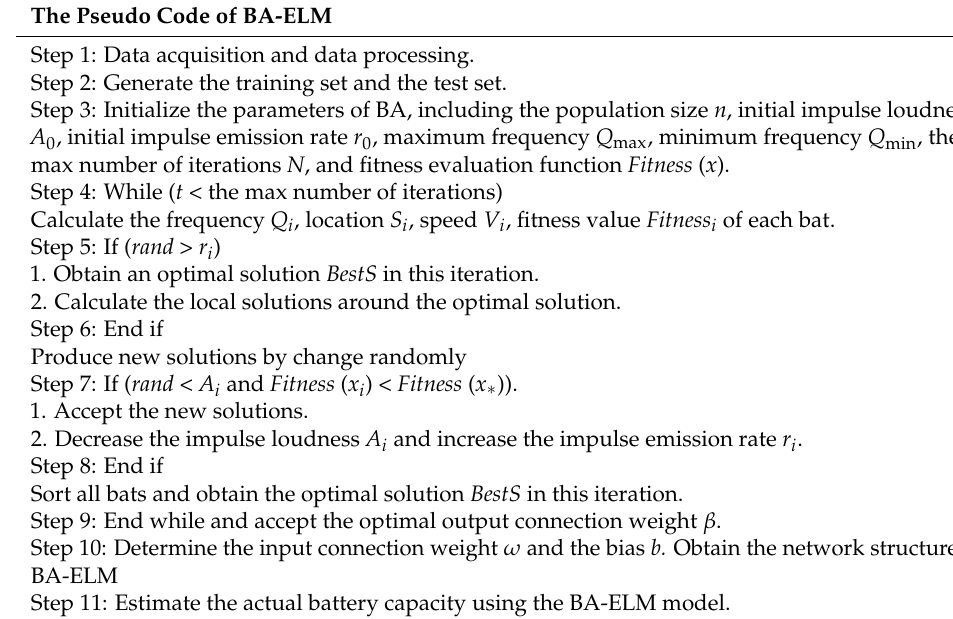
Table 5. The pseudo code of the proposed model. The Pseudo Code of